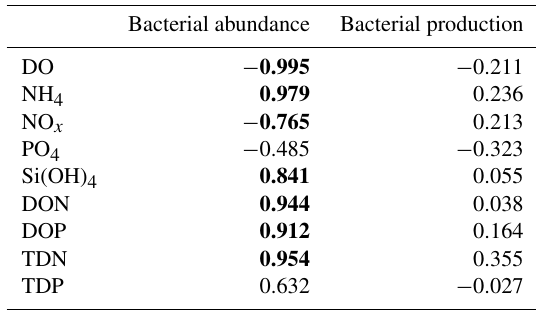
Table B1. Pearson correlation coefficients ( r ) between nutrient concentrations, bacterial abundance, and production rates. Averages of three replicates per time step were used ( N = 7). Significant correlations are marked in bold ( p< 0 .